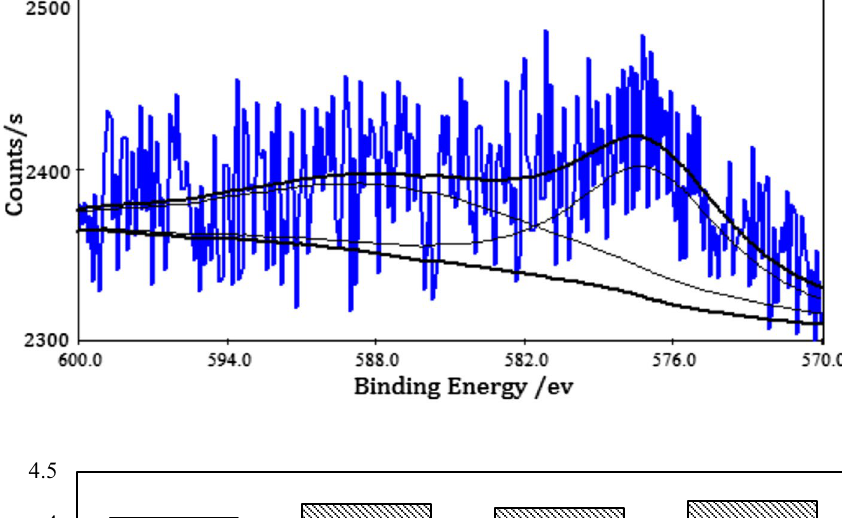
Fig. 3 Speciation analysis of chromium at different pH condi- tions